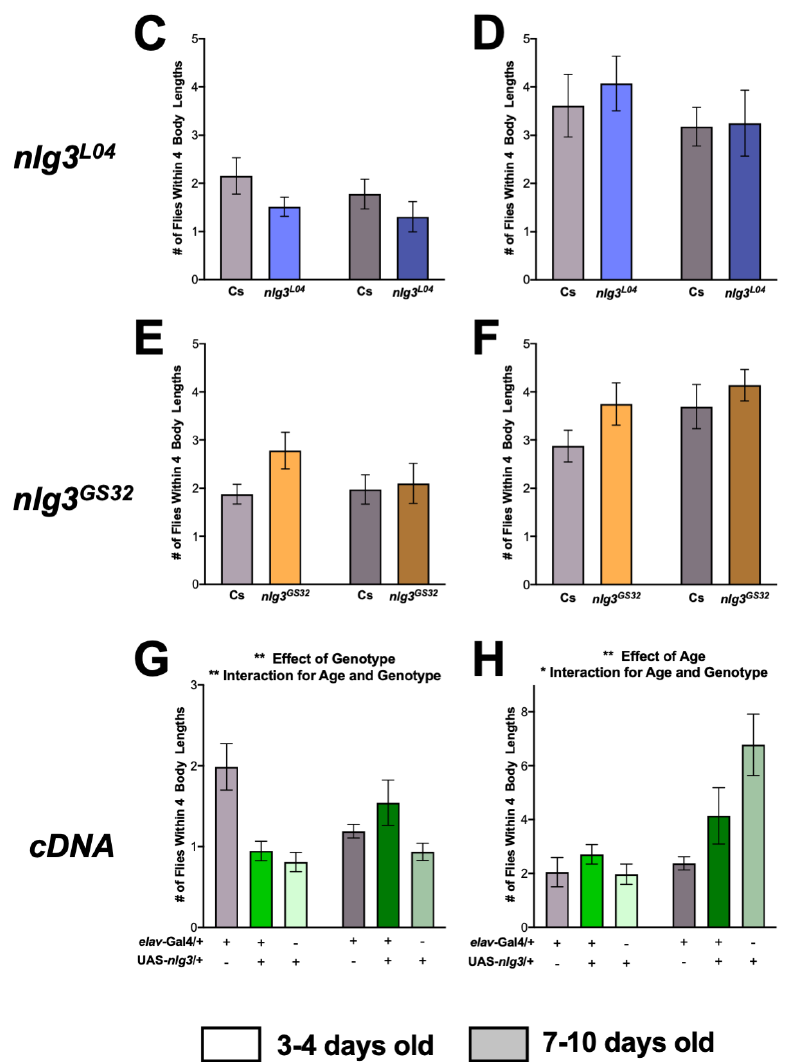
Figure 2. Nlg3 Def1 but not nlg3 L04 or nlg3 GS32 have altered social space. Mean number of flies within four body lengths (4BL) ± s.e.m. ( A ) Males nlg3 Def1 have significantly less flies within 4BL than male Cs, regardless of their age (two-way ANOVA: F 1,49 =5.538 , p = 0.0227; 3–4 days old: n = 15 trials for Cs, n = 13 for nlg3 Def1 ; 7–10 days old: n = 14 for Cs and n = 11 for nlg3 Def1 ). ( B ) No difference was observed between young Cs and nlg3 Def1 females; however old nlg3 Def1 females had less flies within 4BL than Cs (Welch’s t-test: T 13.62 =2.097 , p = 0.0276; 3–4 days old: n = 12 trials for Cs and nlg3 Def1 ; 7–10 days old: n = 14 for Cs and n = 7 for nlg3 Def1 ). The 7–10 day-old nlg3 Def1 and Cs females were tested on different days than 3–4 day-old flies, they were therefore plotted on separate axis and Welch’s t-tests were performed on the difference between nlg3 Def1 and Cs at each age. There was no effect of age, genotype, or any interaction for nlg3 L04 male ( C ) or female ( D ) and nlg3 GS32 male ( E ) or female ( F ). Color coding of bars corresponds to type of mutation: grey represents Cs, red represents nlg3 Def1 , blue represents nlg3 L04 , and orange represents nlg3 GS32 . The p -values were determined using a two-way ANOVA . Error bars represent s.e.m. ( C – D ): Males: 3–4 days old: n = 9 trials for Cs and n = 8 for nlg3 GS32 ; 7–10 days old: n = 9 for Cs and nlg3 GS32 . Females: 3–4 days old: n = 9 for Cs and n = 8 for nlg3 GS32 ; 7–10 days old: n = 9 for Cs and nlg3 GS32 . E-F: Males: 3–4 days old: n = 9 for Cs and n = 8 for nlg3 L04 ; 7–10 days old: n = 9 trials for Cs and nlg3 L04 . Females: 3–4 days old: n = 9 for Cs and n = 7 for nlg3 L04 ; 7–10 days old: n = 7 for Cs and nlg3 L04 . ( G ) The 3–4 day-old elav > nlg3 males were not different from UAS- nlg3 /+ control